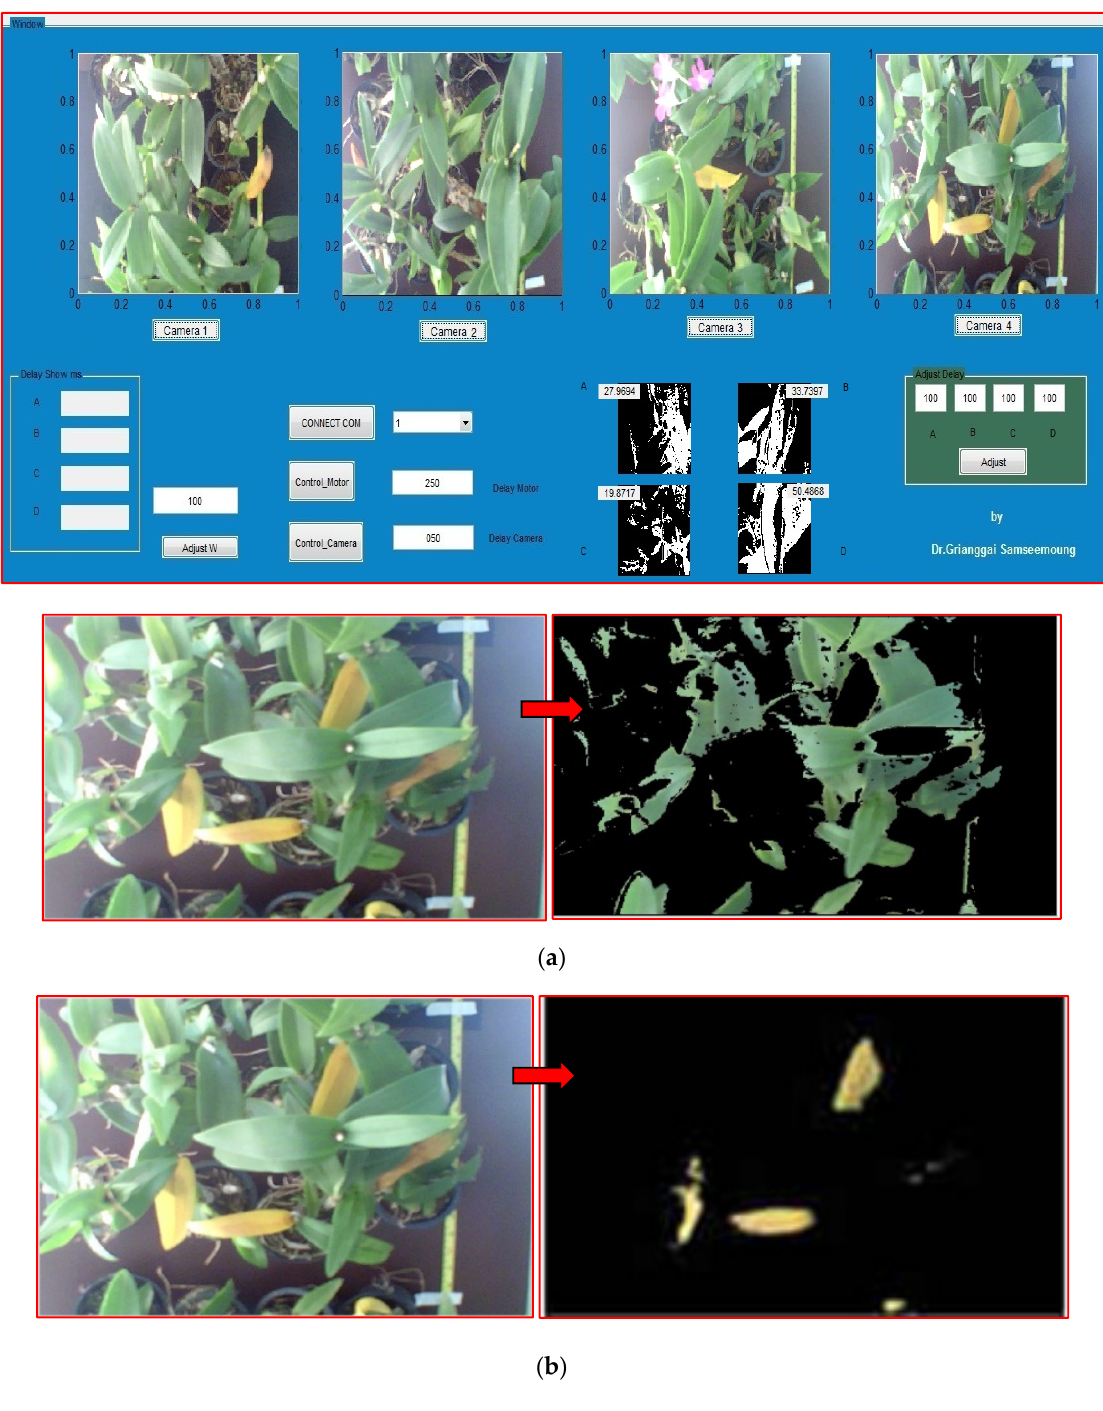
Figure 5. Image processing software with green color thresholding: ( a ) Plant growth stage determination by segmentation; ( b ) Infested area segmentation for target detection.